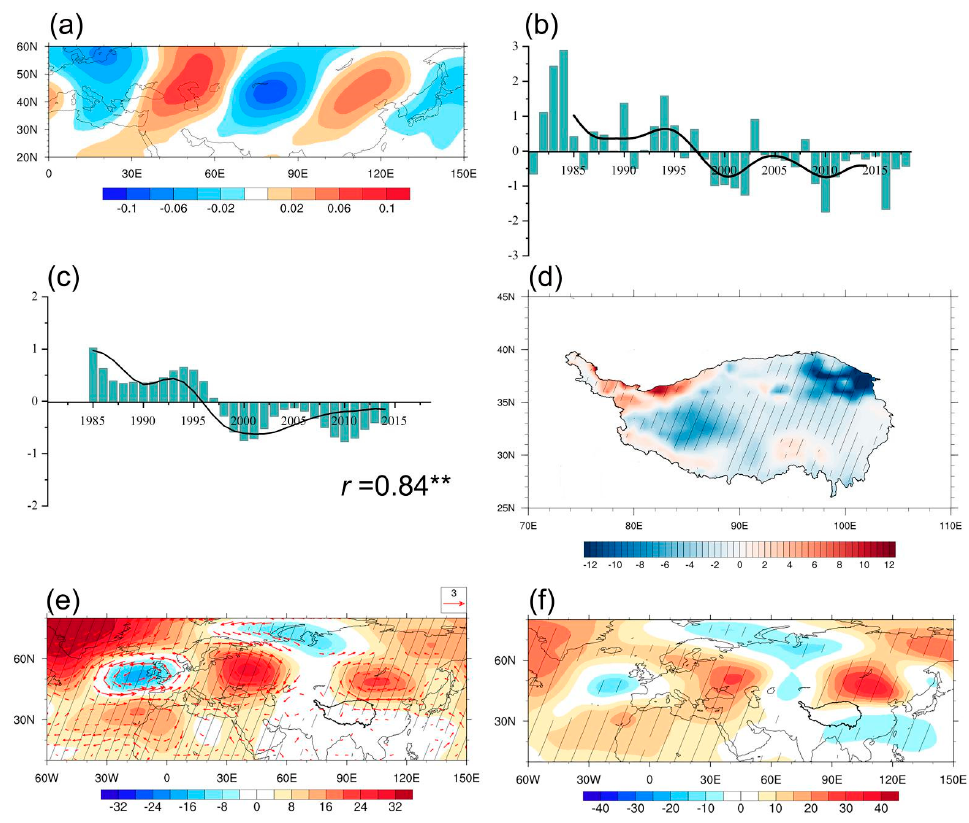
Figure 11. ( a ) The first EOF of summer means 200 hPa meridional wind over the region 20–60 ◦ N, 0–150 ◦ E for the period 1981–2018. ( b ) Normalized time series of SRPindex (column) and its interdecadal component (line). ( c ) Normalized time series of interdecadal component of SRP index (column) and PC1-ID (line). (**: significant at 99% confidience level). Anomalies in the interdecadal component of sensible heating ( d ), 500 hPa geopotential height (shading, gpm) and the wind exceeding the 95% confidence level (vector, m/s) ( e ), the 200 hPa geopotential height (shading, gpm) ( f ) regressed on SRPI-ID multiplied by − 1. Grid points with statistically significant anomalies passing the 95% confidence level are denoted by oblique lines.